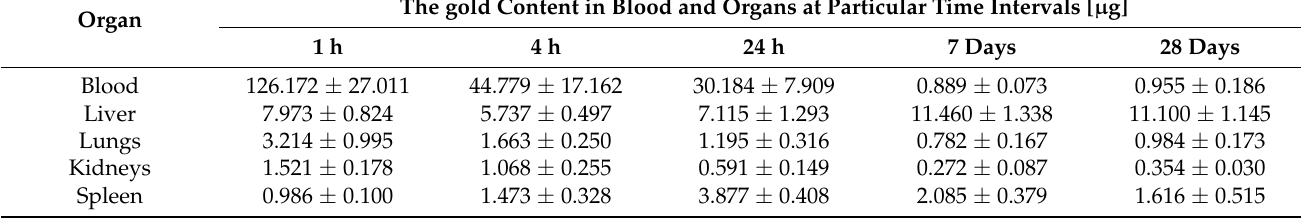
Table 5. Gold content in blood and organs determined by GFAAS in rats at different time intervals after a single i.v. injection of PEG-AuNPs (0.7